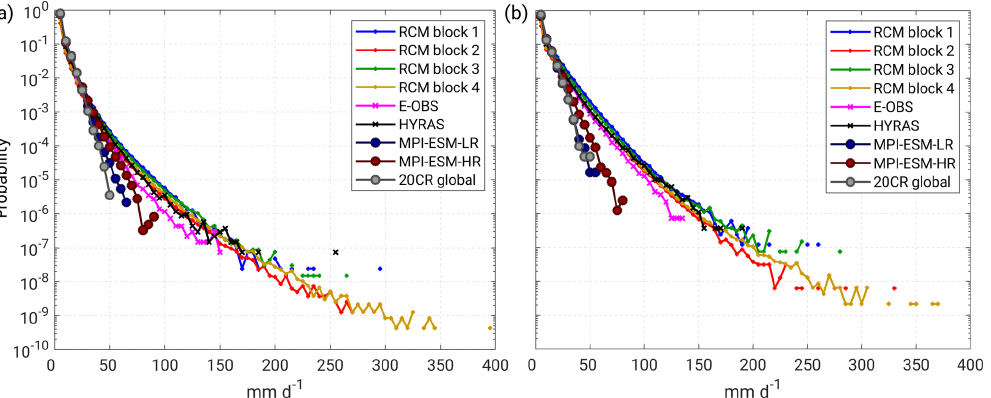
Figure 2. Intensity–probability curves (IPCs) of daily rainfall totals of the RCM simulations (dry-day adjusted), observations (E-OBS and HYRAS), GCM simulations (forcing MPI-ESM data at two resolutions – LR and HR), and global reanalysis data (20CR) for (a) Mid- Europe (ME ∗ ) and (b) the Alps (AL ∗ ), both limited to the HYRAS area during the investigation period TP1b (1951–2006). For the IPCs, every grid cell value at every time step was taken into account without any